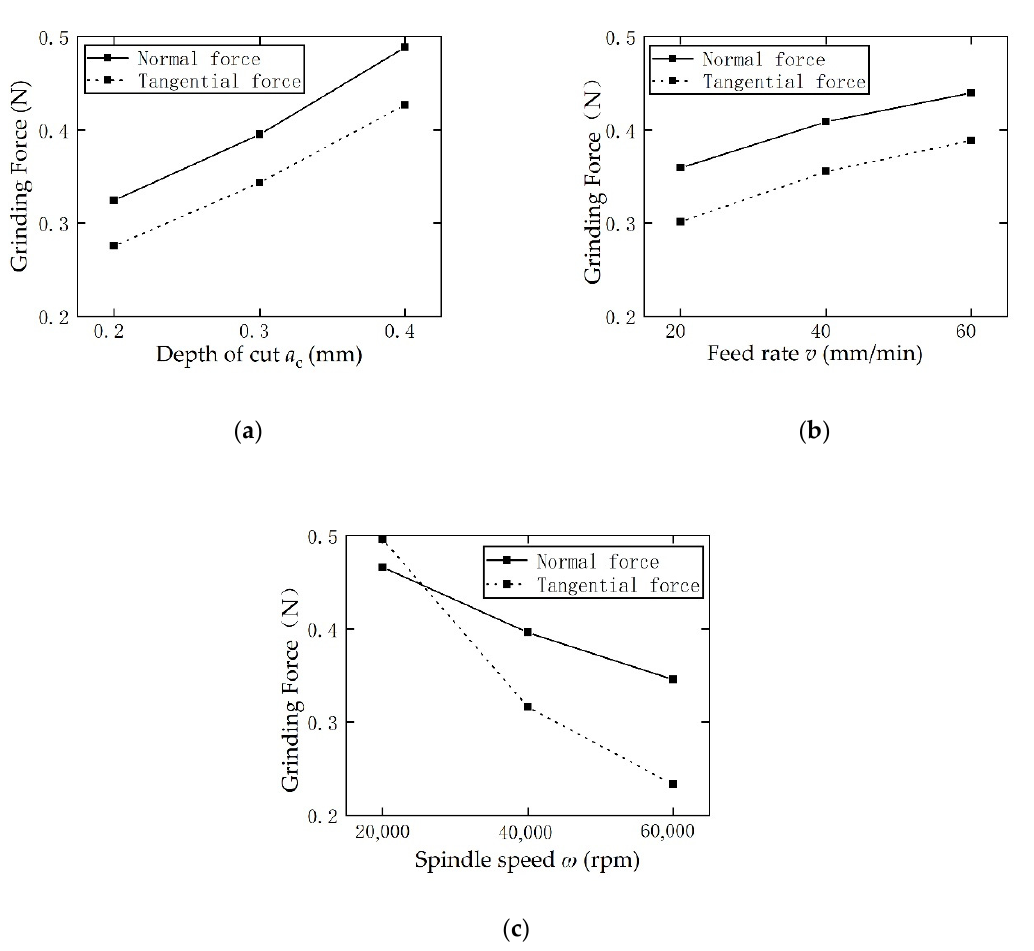
Figure 10. Variation of bone grinding force with variation of process parameters.